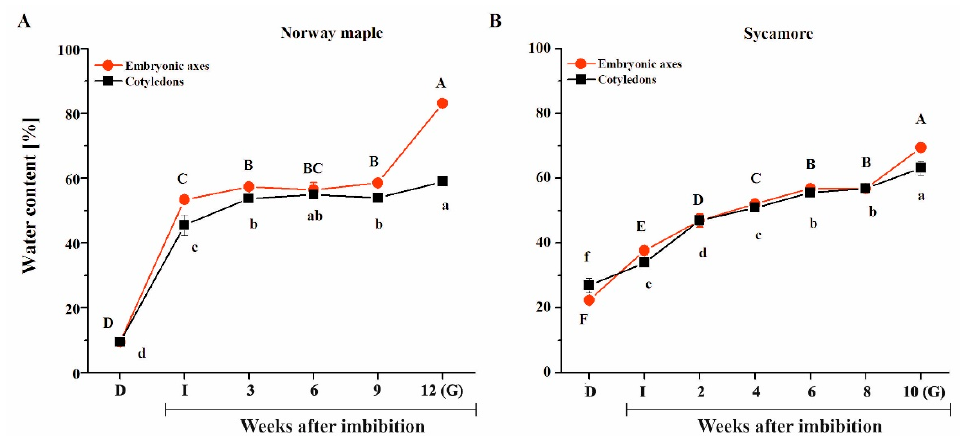
Figure 2. Water sorption isoterms displaying the hydration of the embryonic axes and cotyledons of Norway maple ( A ) and sycamore ( B ) dry seeds and during germination. Abbreviations: D, Dry seeds; I, Imbibed seeds; G, Germinated seeds. Data are the means of three independent replicates ± the standard deviation. Identical letters indicate groups not significantly differentiated according to Tukey’s test.